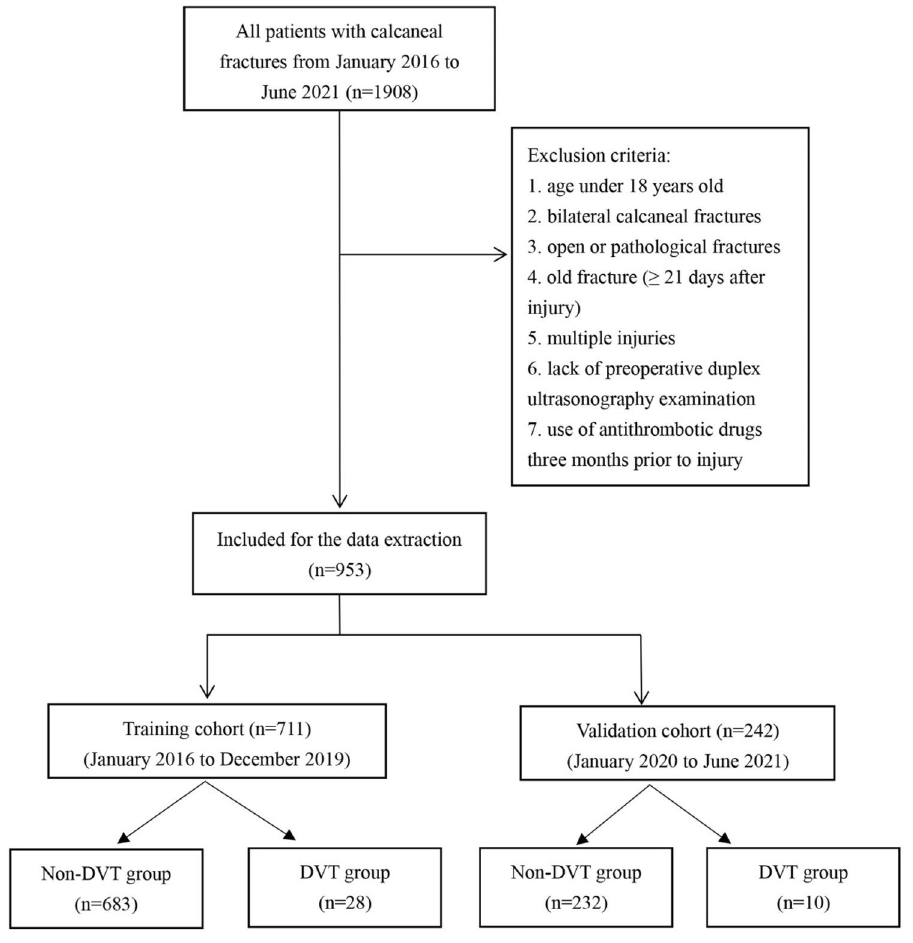
Figure 1. Patients selection